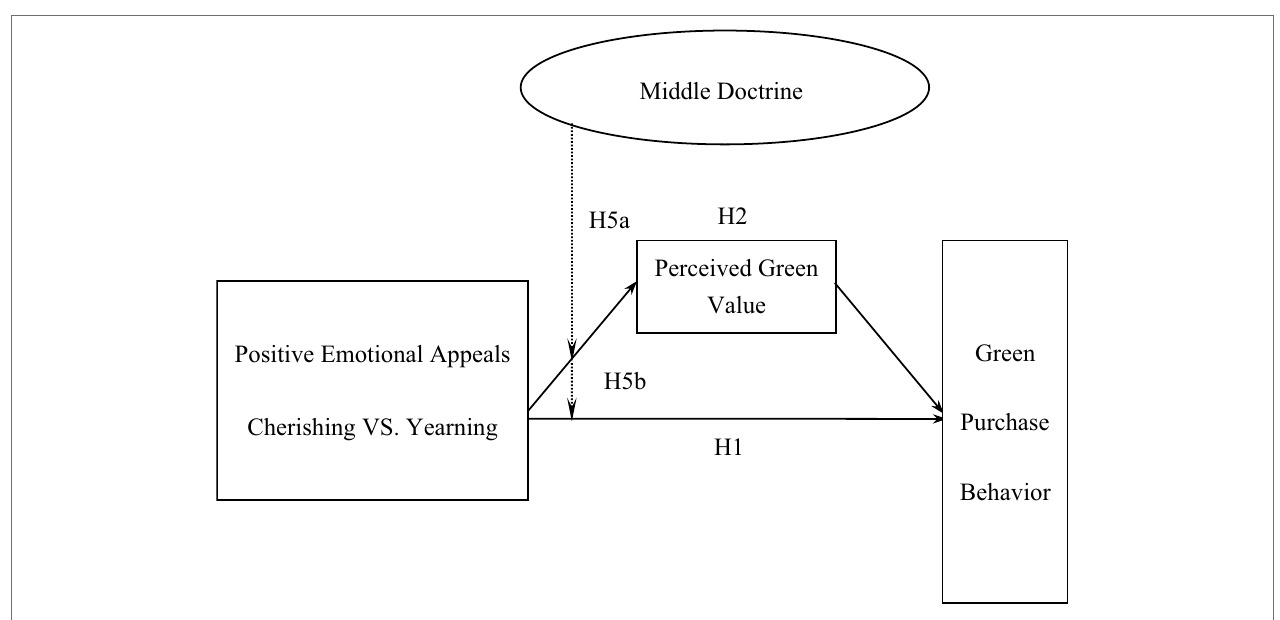
FIGURE 2 | Conceptual model of this study (dimensions of emotions toward a better environment appeals).